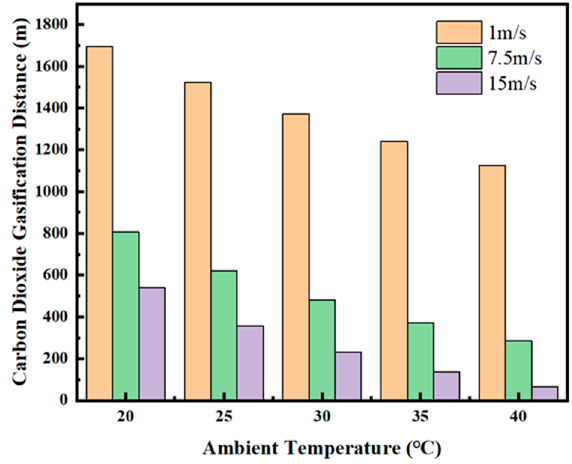
Figure 12. Gasification positions of different temperatures under different airflow velocities at the depth of 400 m.